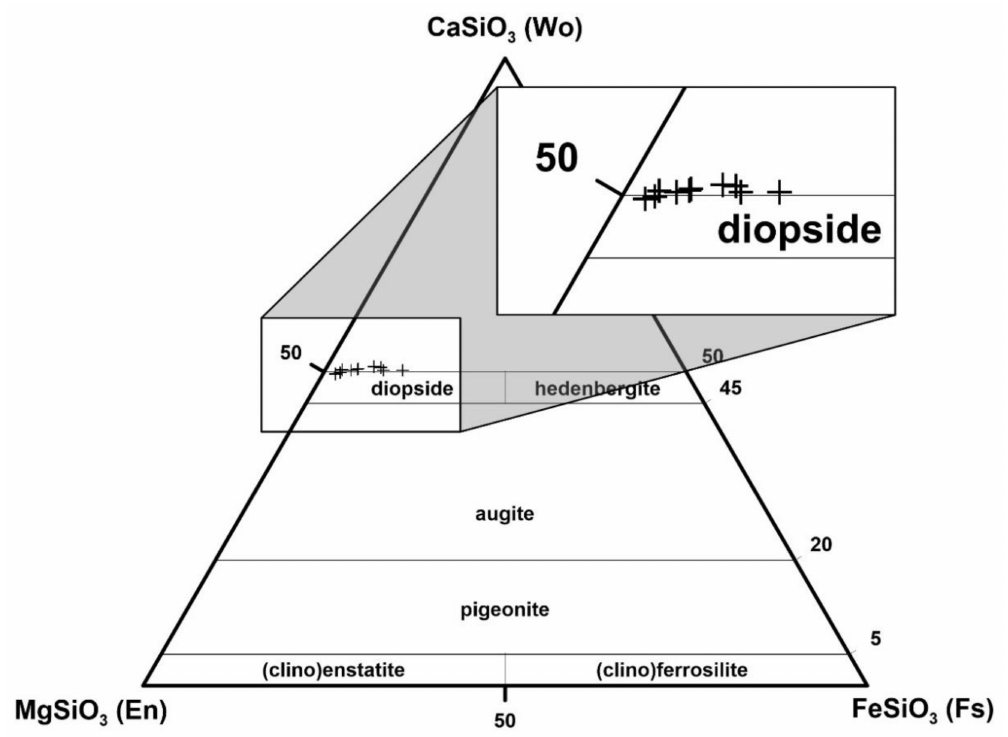
Figure 6. Clinopyroxene analyses projected into Morimoto’s [37] discrimination